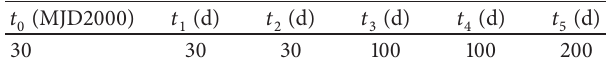
Table 2: Grid-initialization number for each variable in